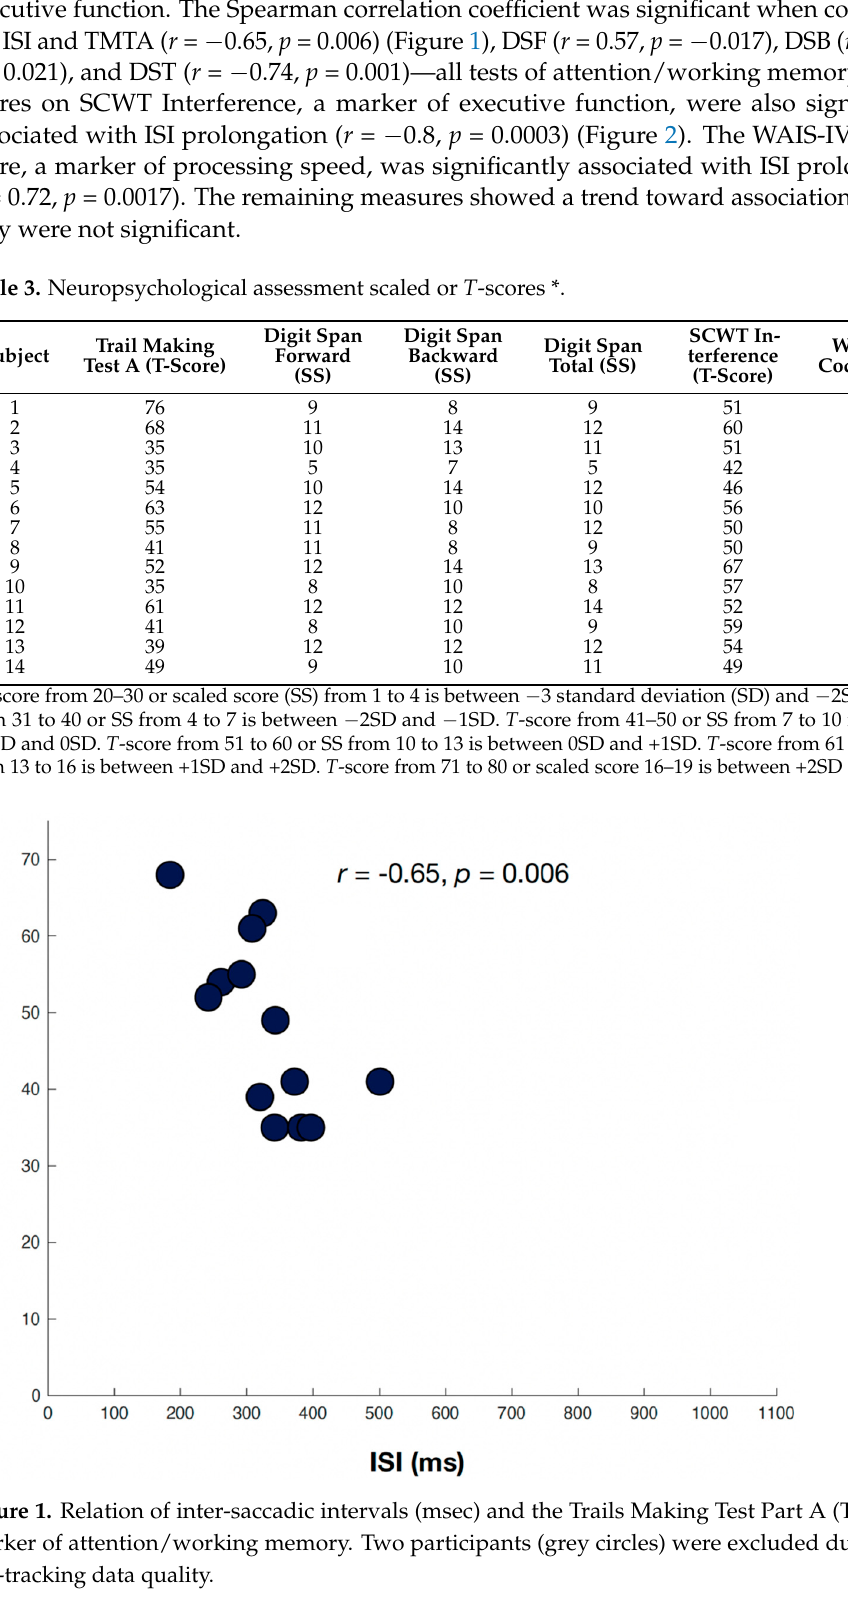
Figure 2. Relation of inter-saccadic intervals (msec) and the Stroop Color Word Interference Test (T-score), a marker of executive function. Two participants (grey circles) were excluded due to poor eye-tracking data quality. 4. Discussion In this small pilot study, we sought to retrospectively explore the relationship be- tween ISI prolongation during KD test performance and standardized neuropsychologi- cal assessments in a cohort of individuals with a history of concussion who had been eval-